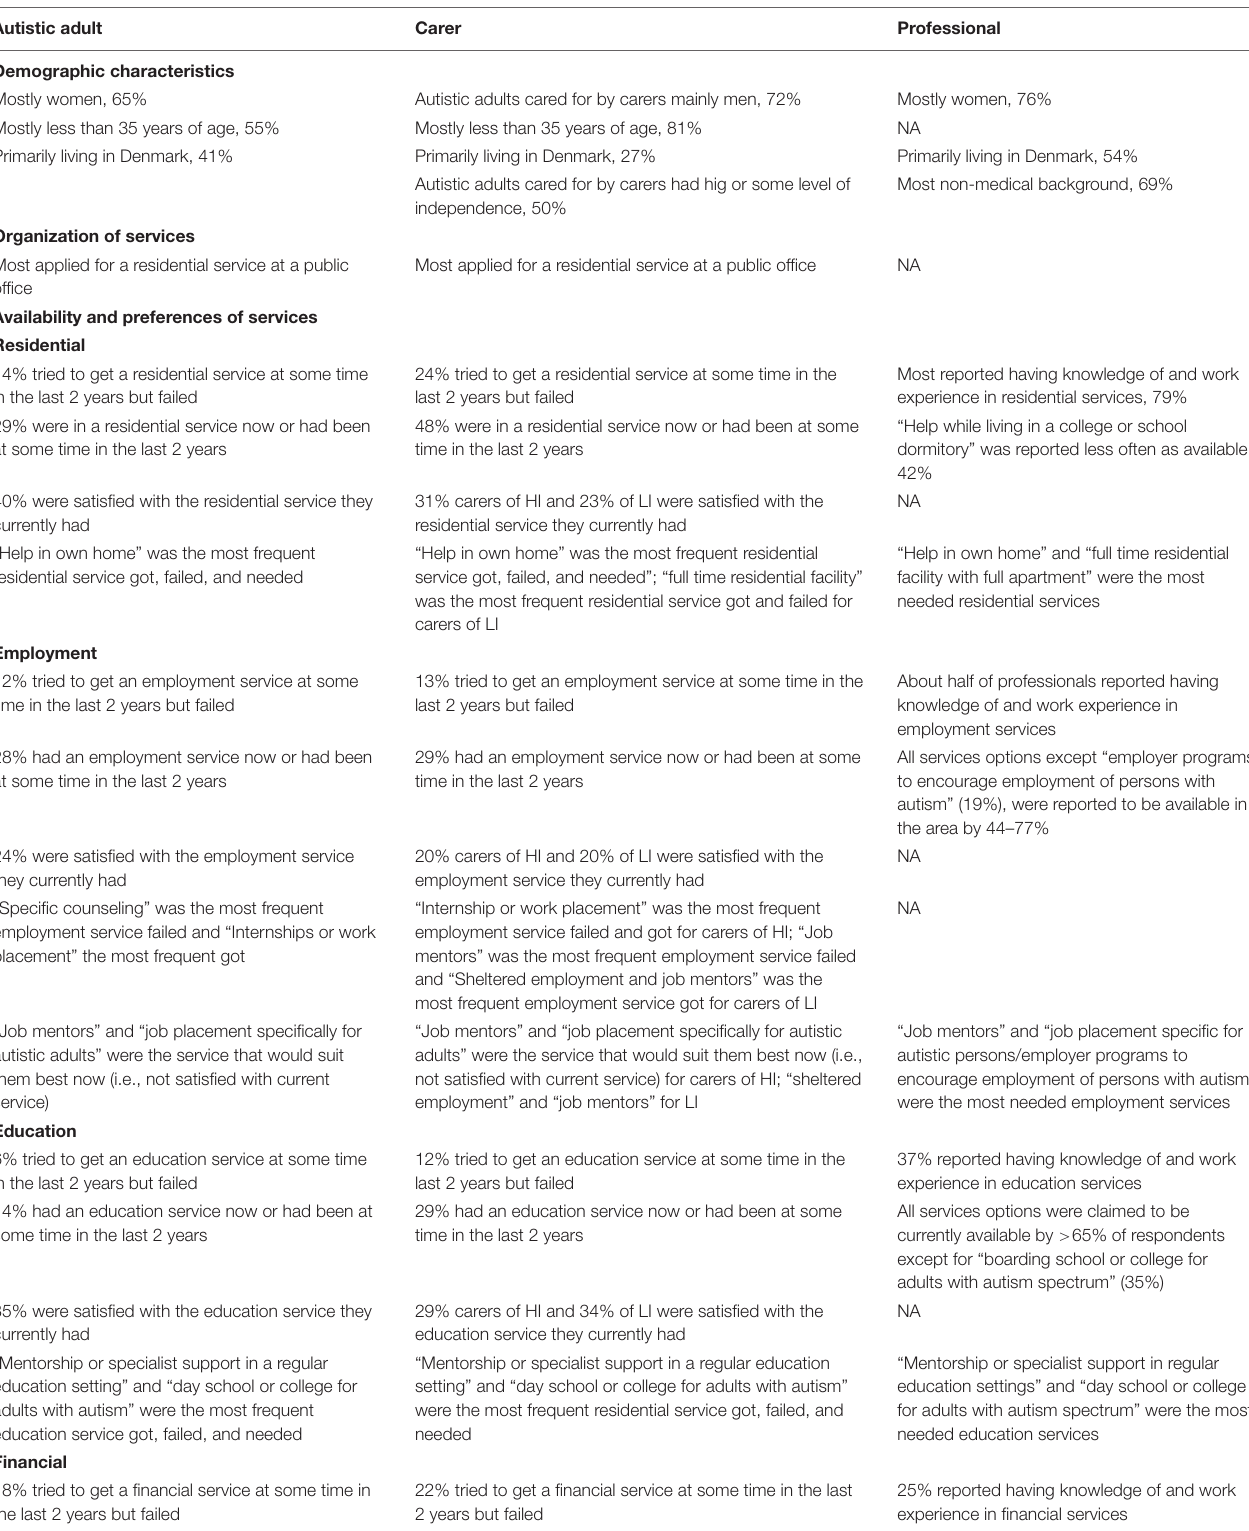
TABLE 1 | Summary of the main